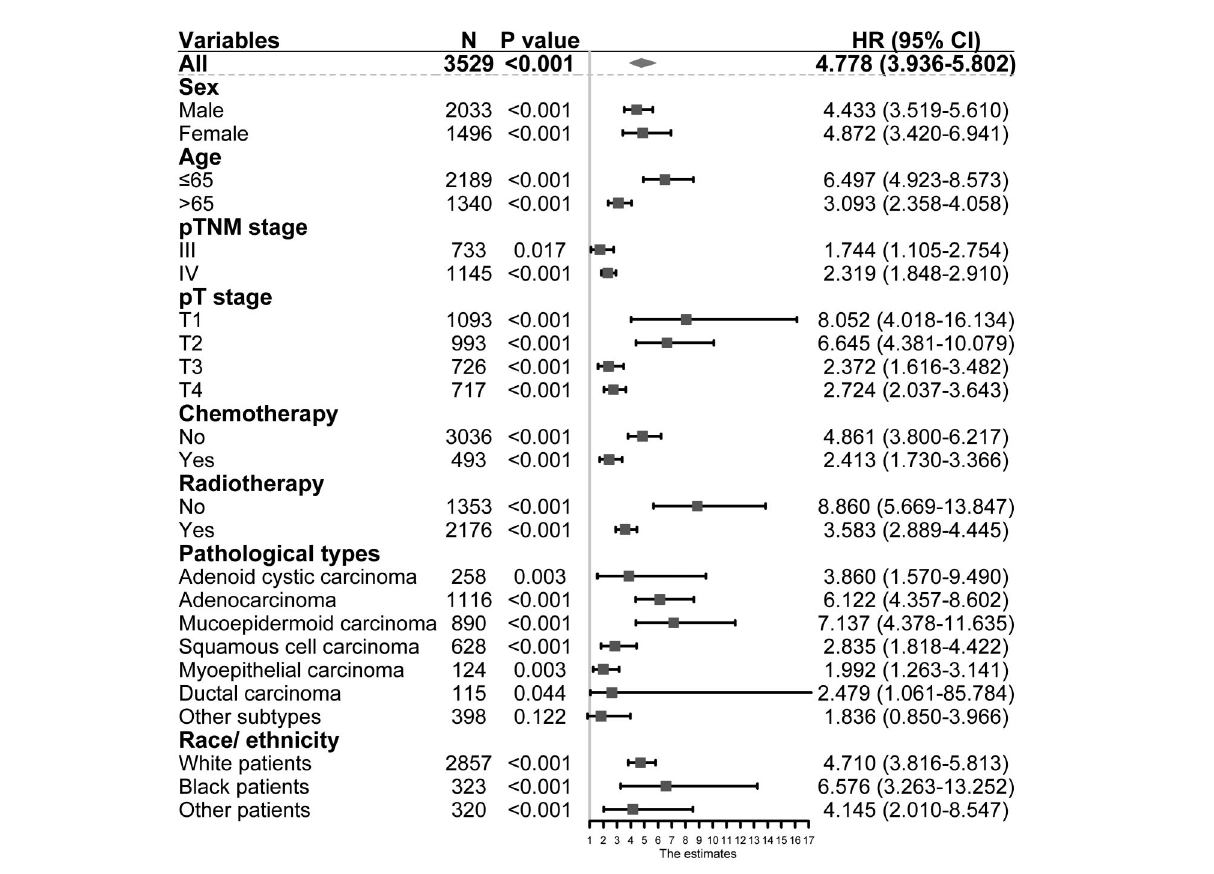
FIGURE 5 | Impact of lymph nodes ratio on survival in population with different